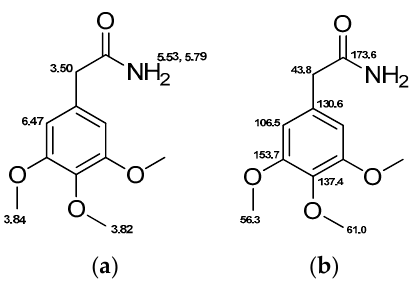
Figure 13. Chemical structure of 7 and relevant NMR shifts for ( a ) 1 H-NMR; and ( b ) 13 C-NMR.